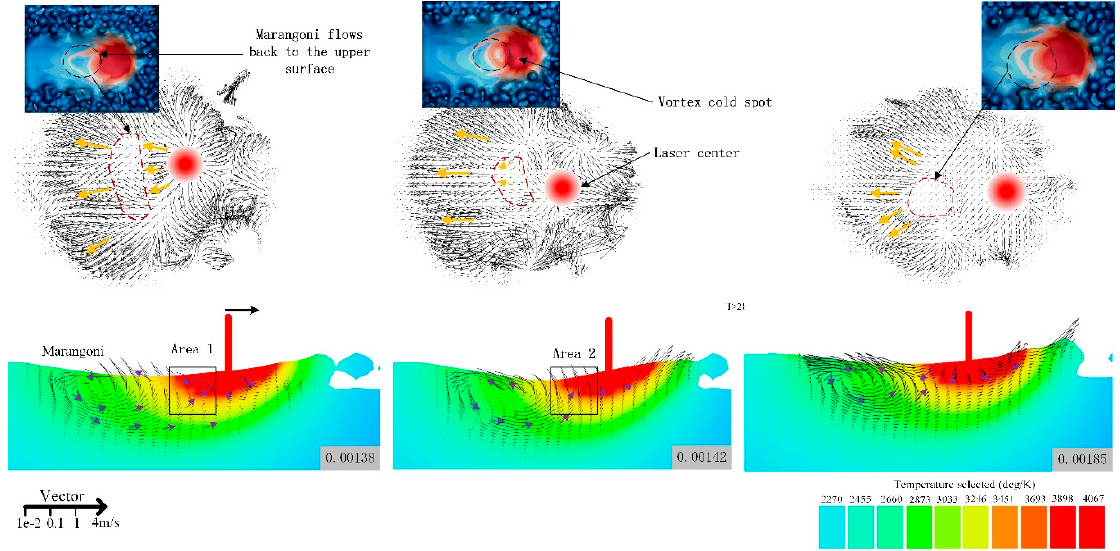
Figure 9. Vector diagram of molten pool at 0.00138 μ s, 0.00142 μ s, and 0.00185 μ s.